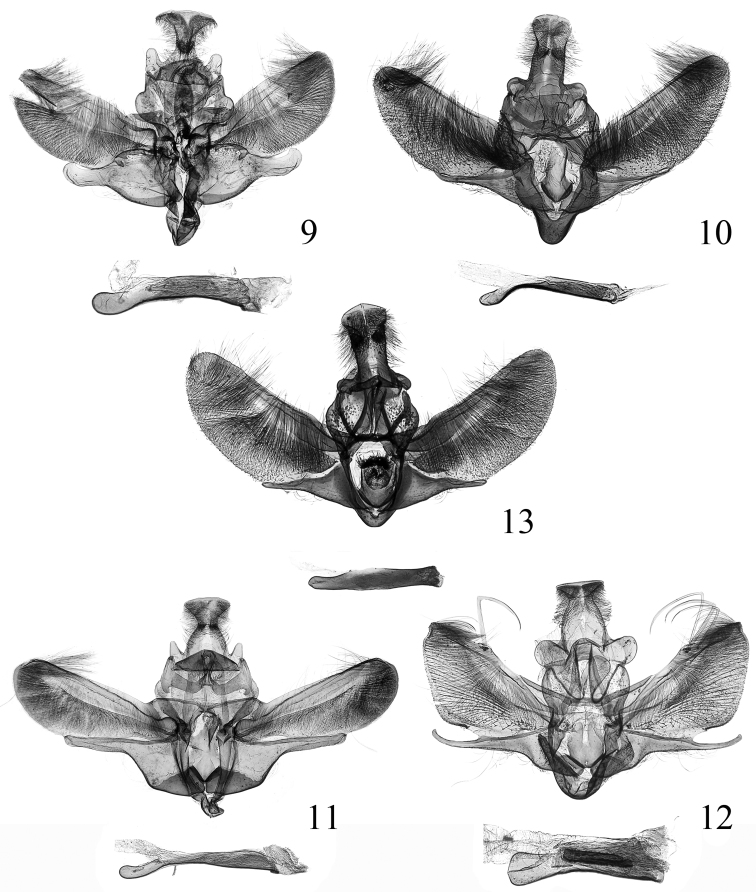
Male genitalia of Endotricha spp. 9
Endotricha dentiprocessa sp. n., holotype, slide no. SYL1102910
Endotricha unicolor sp. n., holotype, slide no. SYL11147 11
Endotricha shafferi sp. n., holotype, slide no. SYL1109412
Endotricha convexa sp. n., holotype, slide no. SYL11043 13
Endotricha whalleyi sp. n. holotype, slide no. SYL11155.